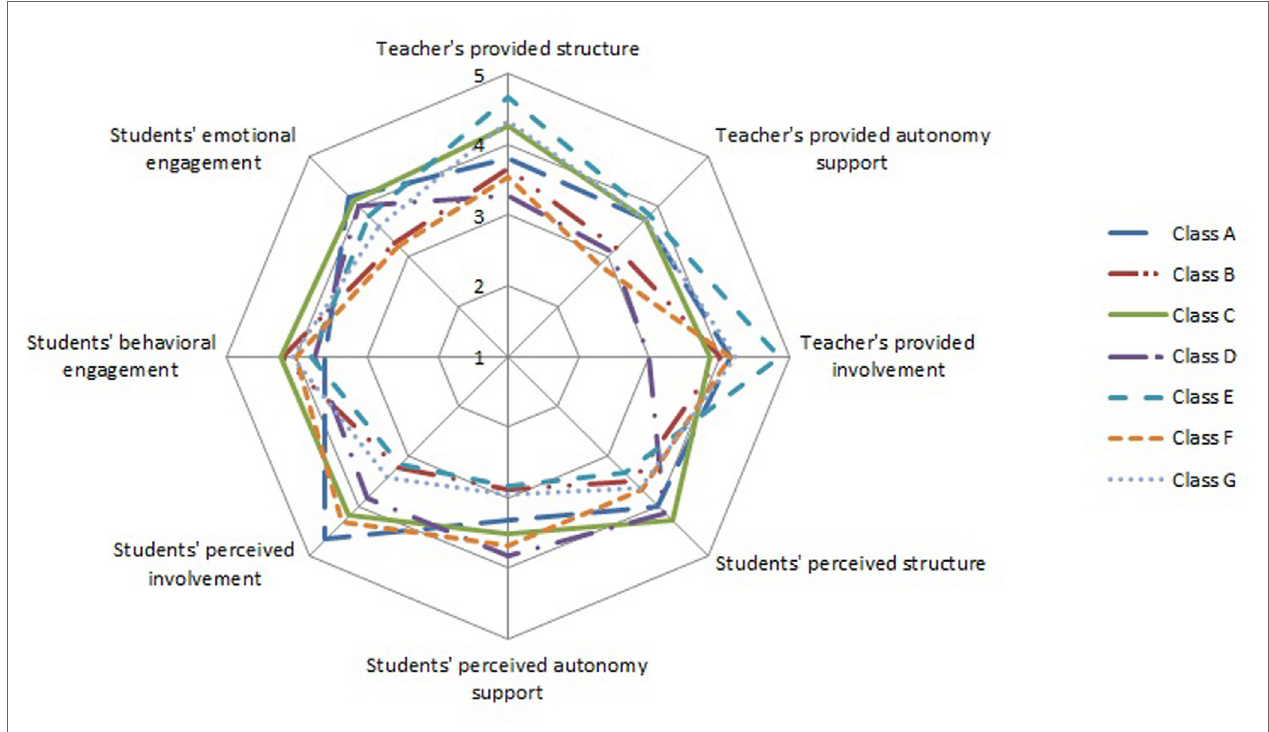
FigUre 2 | Spider chart of teacher and student